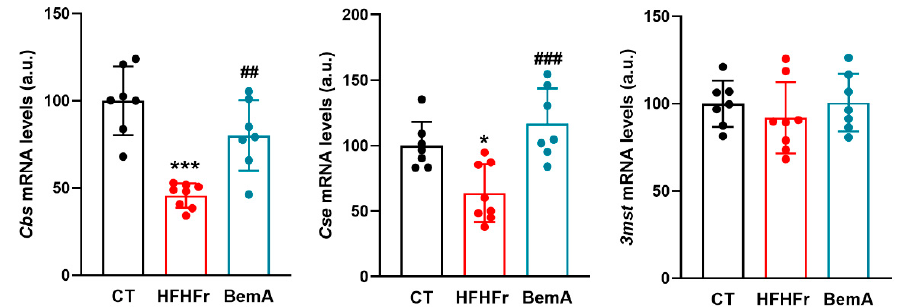
Figure 2. Relative expression of the three enzymes involved in the release of H 2 S in liver tissue: cbs , cse , and 3mst . Bar plots show the relative mRNA levels of cbs , cse , and 3mst genes as mean ± SD, as well as individual values from 7-8 tissue samples, corresponding to the three experimental groups studied: CT (control), HFHFr (high-fat high-fructose), and BemA (HFHFr treated with BemA) female Sprague-Dawley rats. * p < 0.05, *** p < 0.001, vs. CT; ## p < 0.01, ### p < 0.001 vs. HFHFr.